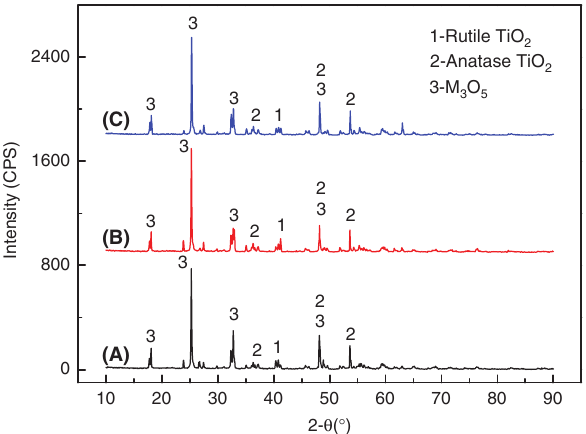
Figure 2: X-ray diffraction (XRD) of high titanium slag before and after microwave drying. (A) raw materials; (B) microwave dried 50 s; (C) microwave dried 90